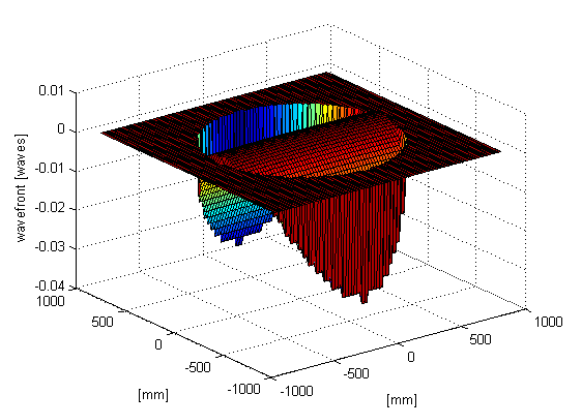
Fig. 1. Wavefront error simulated with Physical Optics Propagation tool in the ZEMAX